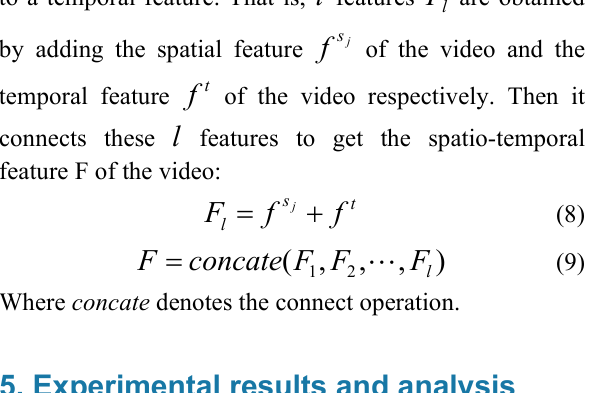
Figure 5. Fusion of spatio-temporal